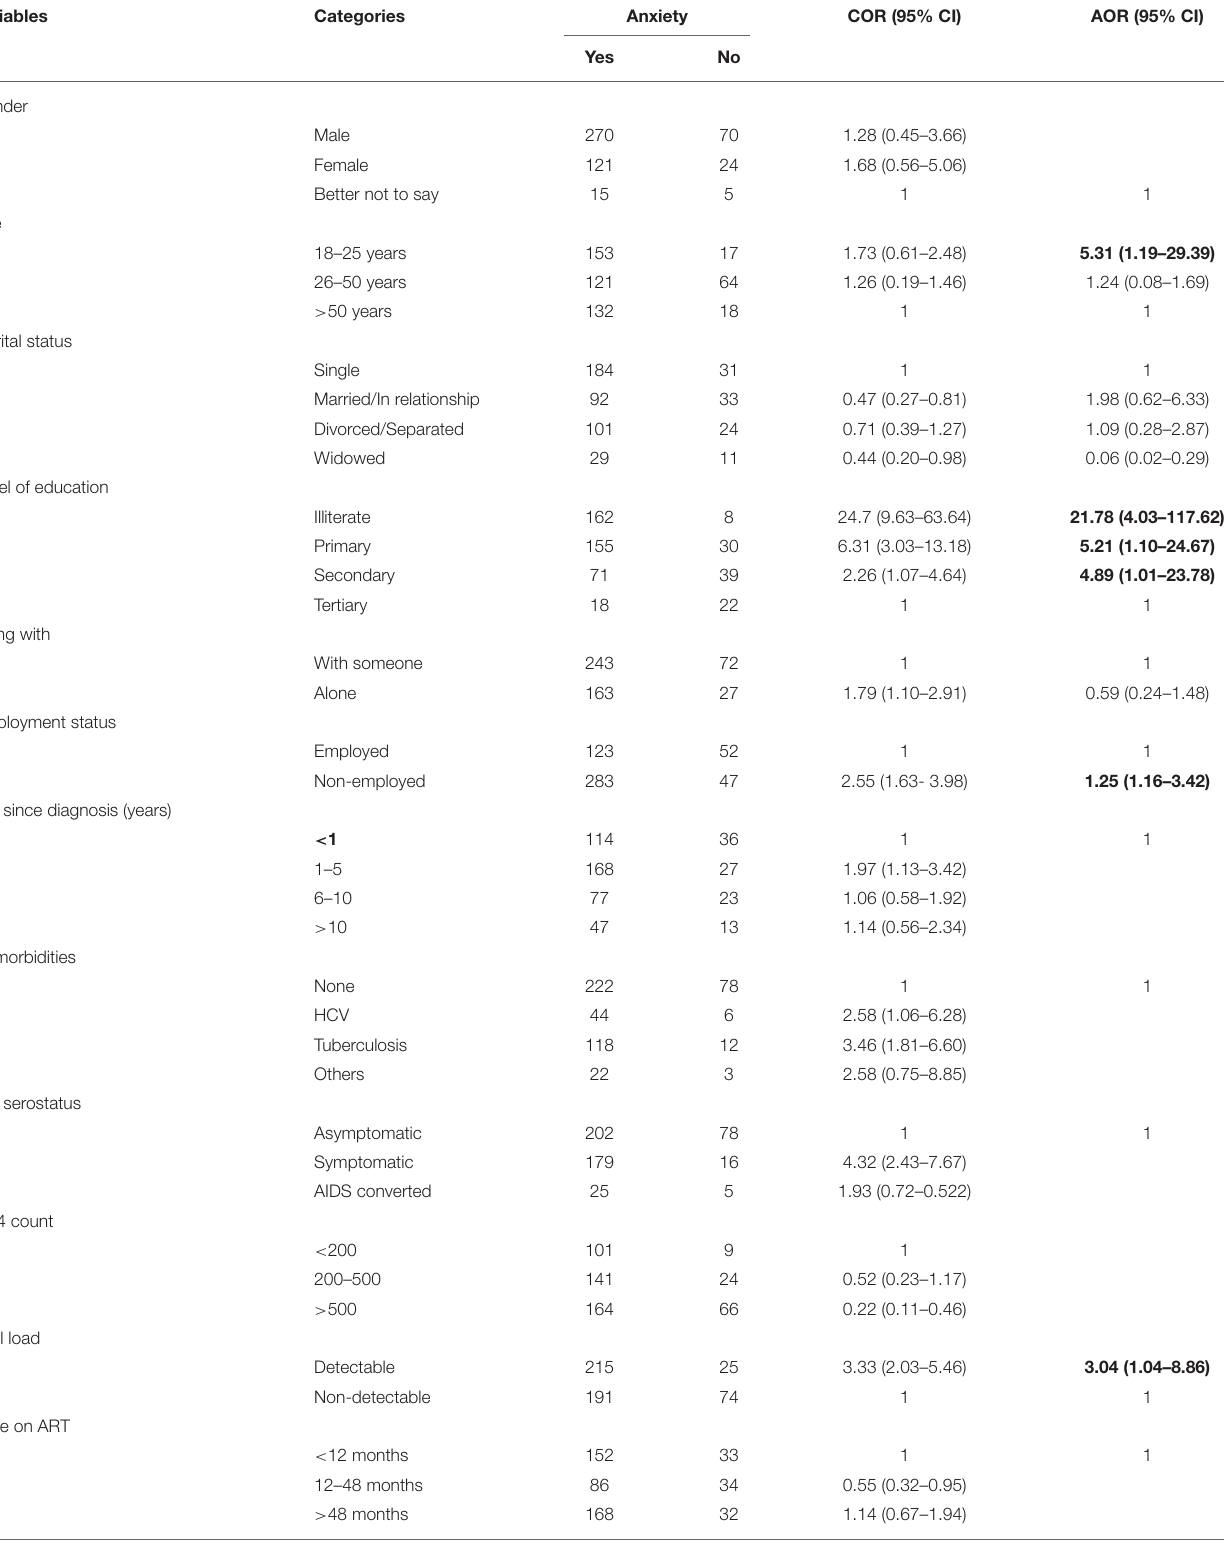
TABLE 4 | Factors associated with